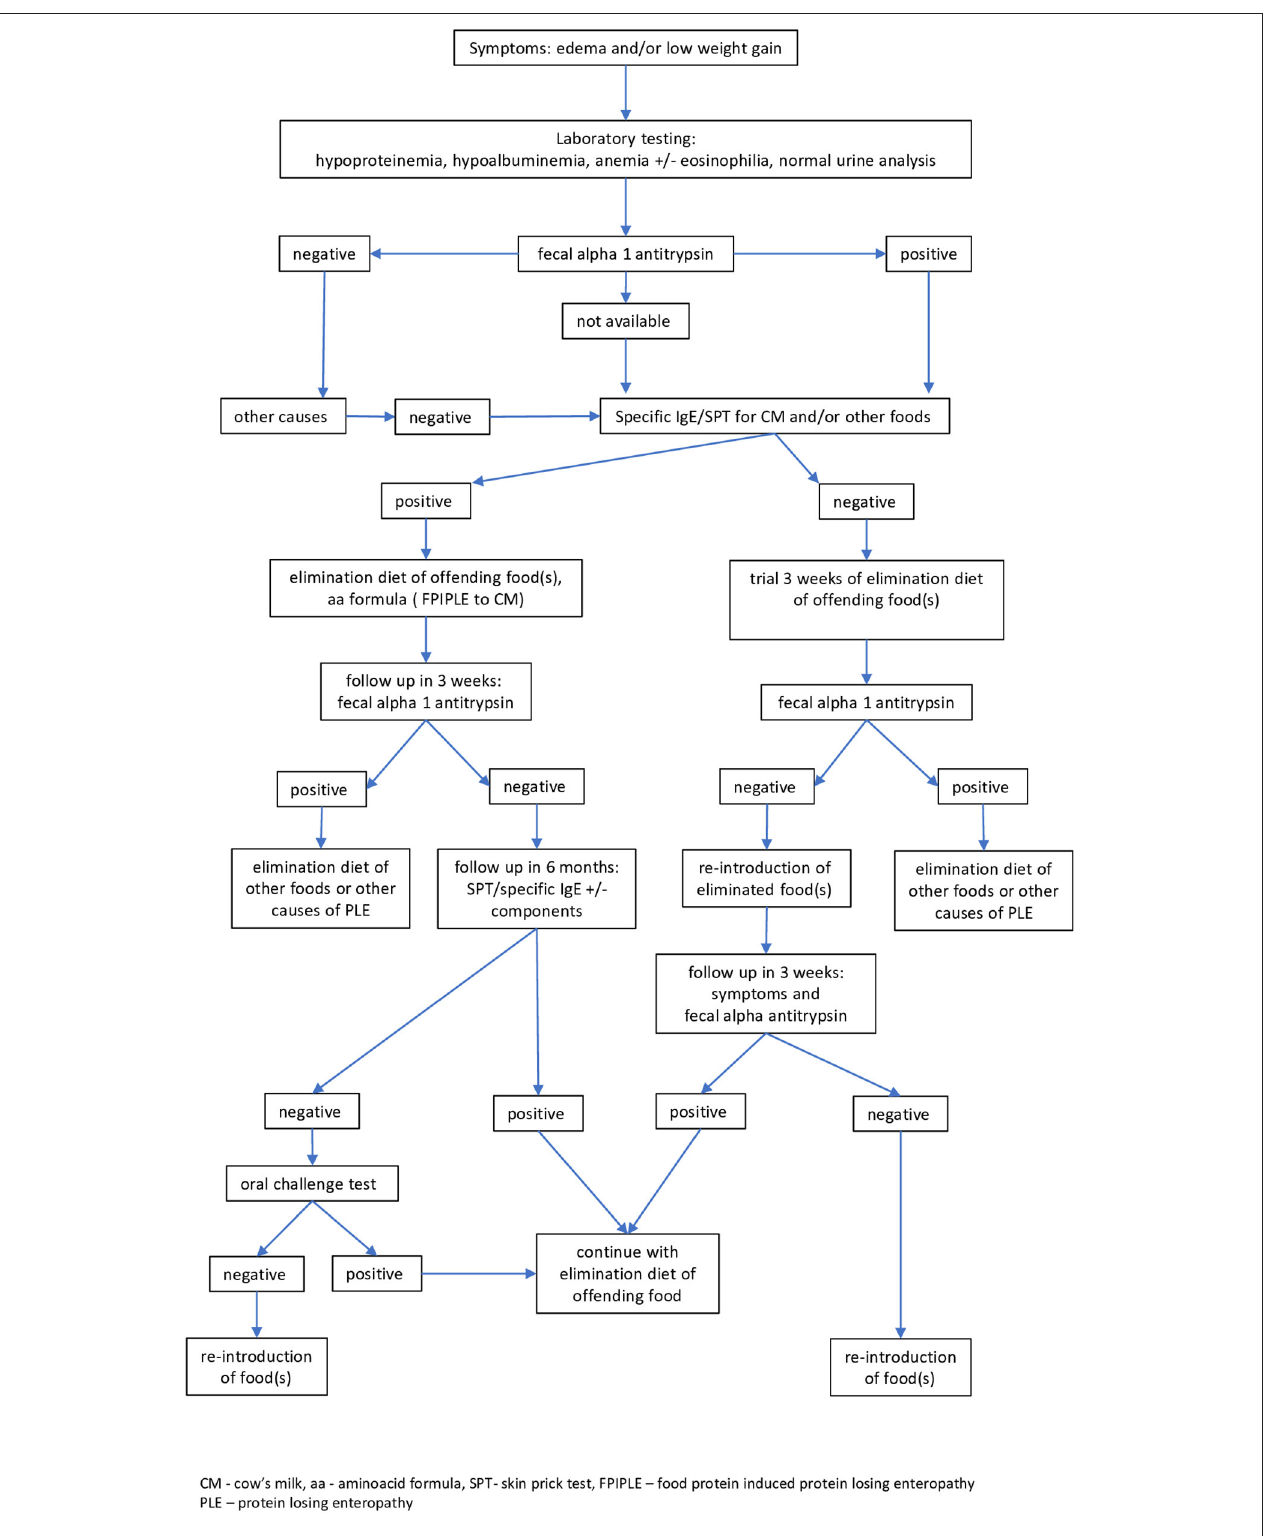
FIGURE 2 | Empirical algorithm for diagnosis and management of food-protein induced protein-losing enteropathy (FPIPLE). Edema and/or low weight gain for age are suggestive of this condition. Laboratory tests should include serum total protein and albumin, hemoglobin/hematocrit, iron, IgE specific for milk and/or other incriminated foods, and fecal α 1 antitrypsin. Skin testing or specific IgE tests should be repeated before an oral food challenge is considered. CM, cow’s milk, aa, aminoacid formula; SPT, skin prick test; FPIPLE, food-protein induced protein-losing enteropathy; PLE, protein losing enteropathy.